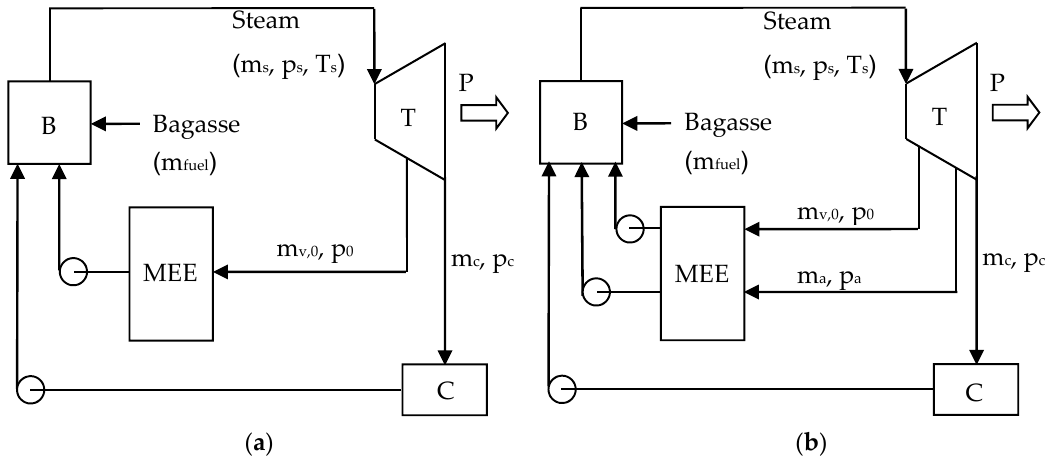
Figure 3. Cogeneration systems that use ( a) the forward-feed multiple-effect evaporator (FF system) and ( b ) the backward-feed multiple-effect evaporator (BF system)